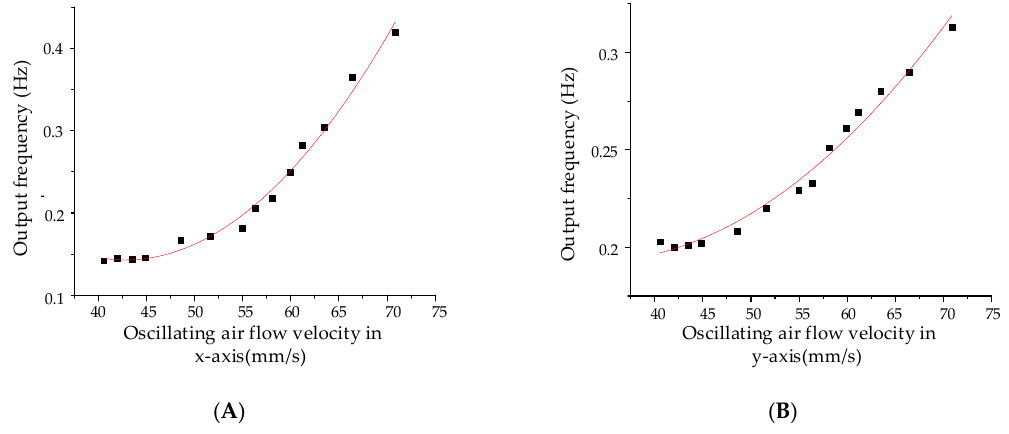
Figure 14. Measurement setup for oscillatory air flow performance evaluation.